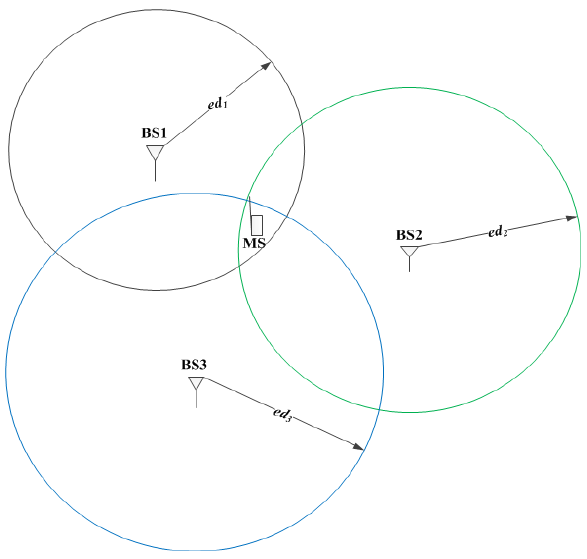
Figure 2. Intersection of three circles based on the estimated distances.